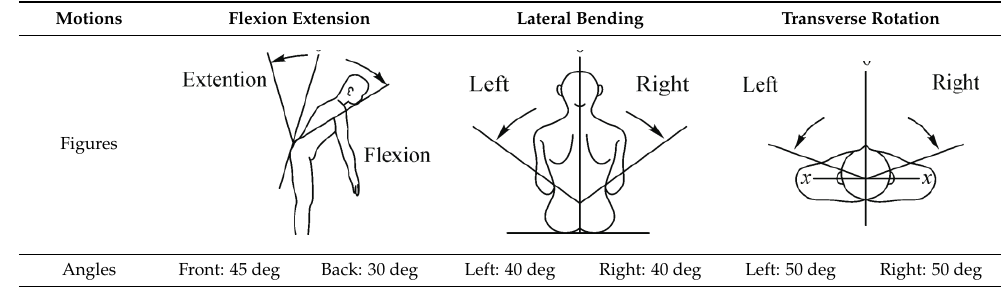
Figure 1. Schematics of the human torso: ( a ) skeleton structure; ( b ) the spine unit. Table 1. Motion ranges of human torso in three modes [17,20]. Table 1. Motion ranges of human torso in three modes [17,20]. Table 1. Motion ranges of human torso in three modes Table 1. Motion ranges of human torso in three modes [17,20].